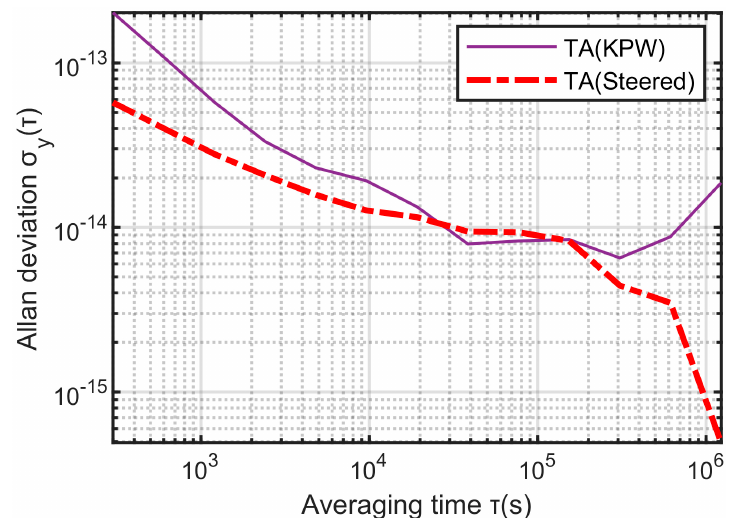
Figure 15. The frequency stability of TA(Steered) and TA(KPW). It can be seen from Figure 15 that the frequency stability of TA(Steered) in this paper is better overall. When the sampling intervals are 300 s, 1 day, and 1 × 10 − 7 s, its frequency stability is 5.73 × 10 − 14 , 9.17 × 10 − 15 , 4.93 × 10 − 16 . Compared with the frequency stability of TA(KPW), when the sampling interval is 300 s, the frequency stability is improved by 71%; when the sampling interval is 1 day, the frequency stability of the two is equivalent; when the sampling interval is 1 × 10 6 s, the frequency stability is increased by 94%. Com- pared with the traditional KPW time-scale algorithm, the method proposed in this paper has significantly improved the short-term and long-term stability of the time-frequency signal output. The frequency stability comparison between TA(Steered) and 24 single clocks is shown in Figure 16 and Table